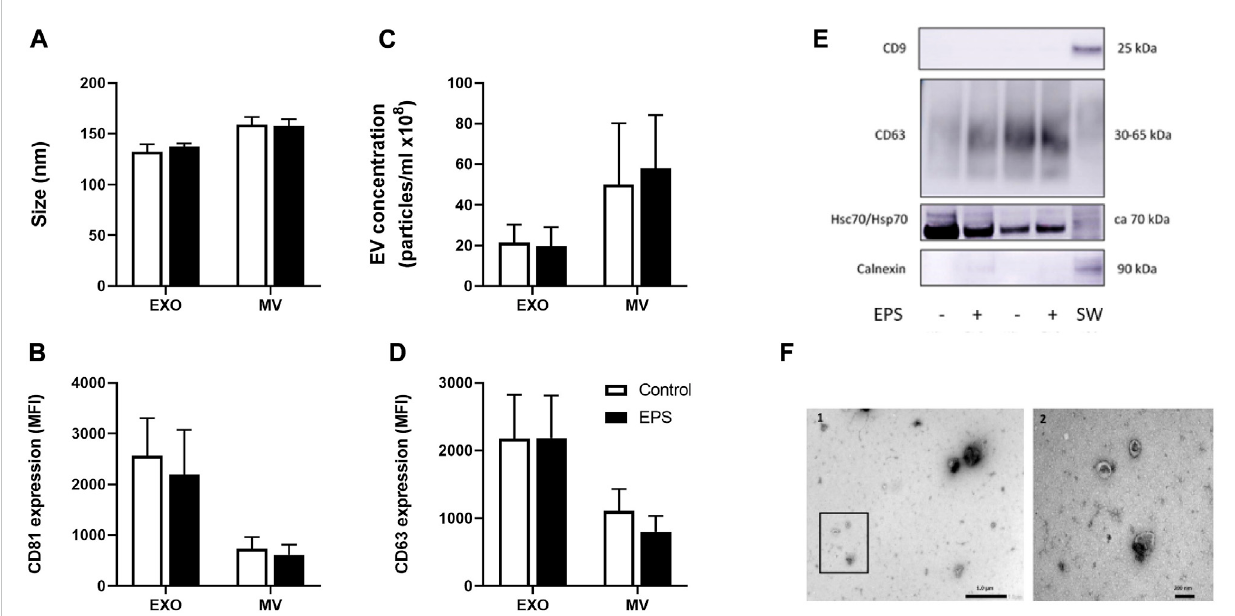
FIGURE 2 Characterization of myotube derived extracellular vesicles (EVs). Human myotubes were exposed to electrical pulse stimulation (EPS) for 24 h, and cell derived EVs were collected for 24 h thereafter. Size (A) and concentration (C) of exosomes (EXO) and microvesicles (MV) were measured by nanoparticle tracking analysis (NTA). The presence of EV markers on exosomes and MV captured by anti-CD81-coated magnetic beads were detected with PE-conjugated CD81 (B) and CD63 (D) antibodies by fl ow-cytometry (BD Accuri C6 fl ow cytometer). Presence of CD9, calnexin, and heat shock protein 70 (Hsc/Hsp70) on exosomes were measured by Western blotting (E) . Cell lysates of SW480 cells (SW) were used as control. Transmission electronmicroscopy(TEM)imagesofskeletalmusclecellderivedEVs (F) .1.FreshlyisolatedEVsfromconditionedmediafromhumanmyotubes,scalebar